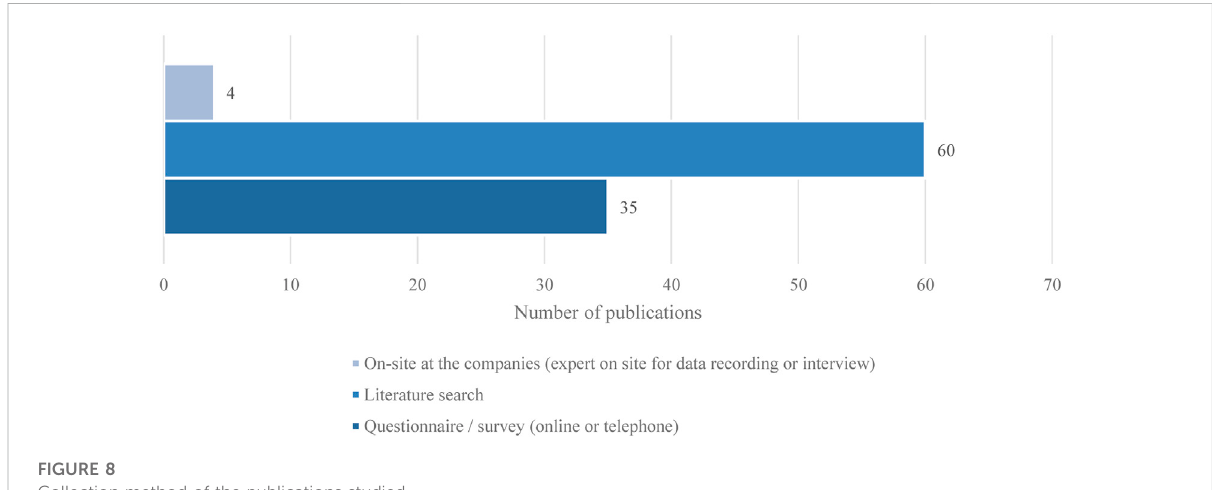
FIGURE 8 Collection method of the publications